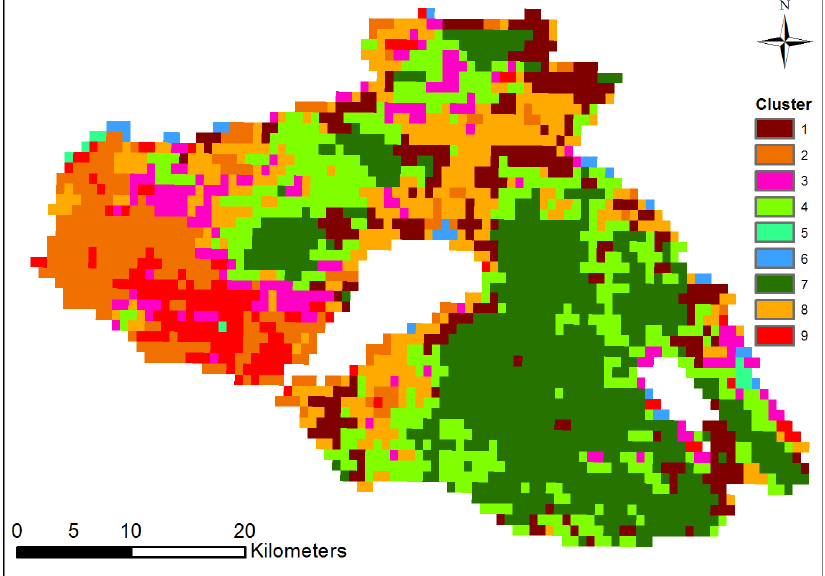
Figure 8. Spatial distribution of optimal nine clusters. Pixels of each cluster show similar NDVI time series based on the dynamic time warping (DTW) similarity algorithm. Table 1. Length of distinct LULC for each